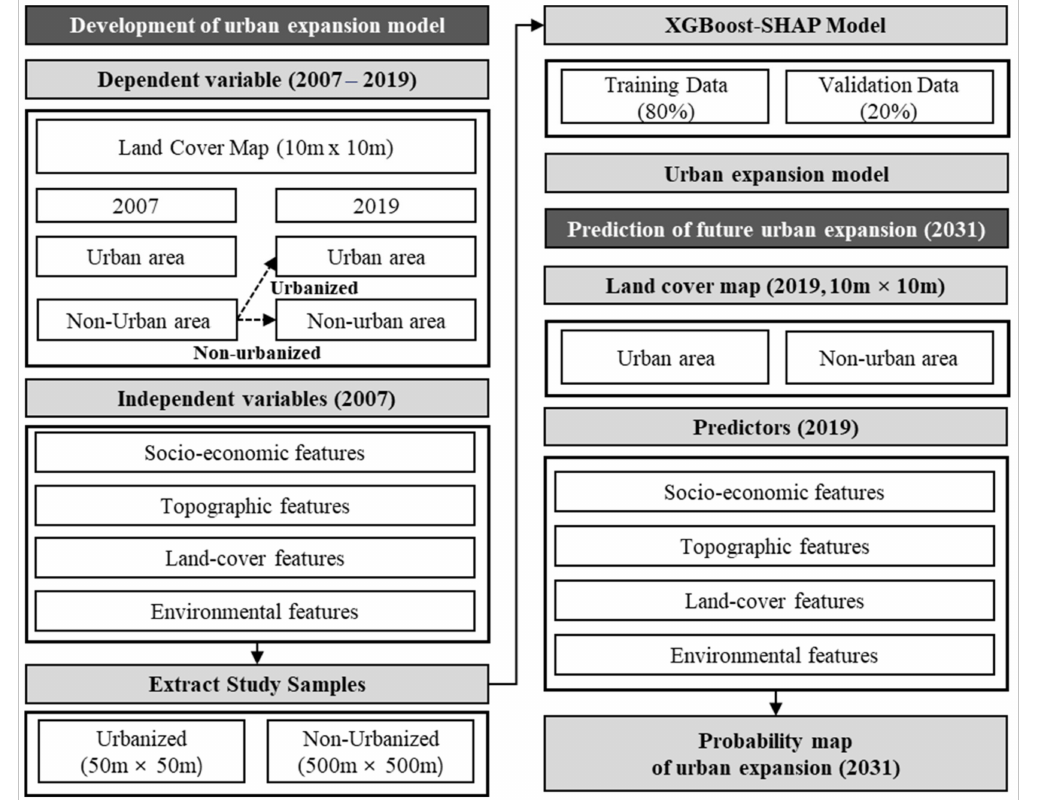
Figure 3. Research